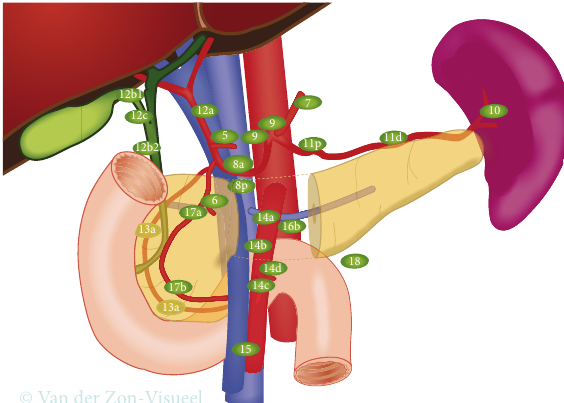
Figure 4: Peripancreatic lymph node stations. According to the International Study Group on Pancreatic Surgery guidelines during distal pancreatectomy for cancer lymph nodes in stations 10, 11, and 18 have to be resected. Resection of lymph nodes in stations 8a and 9 is optional, but it is suggested to be included in the resection in case of cancer located in the body of the pancreas